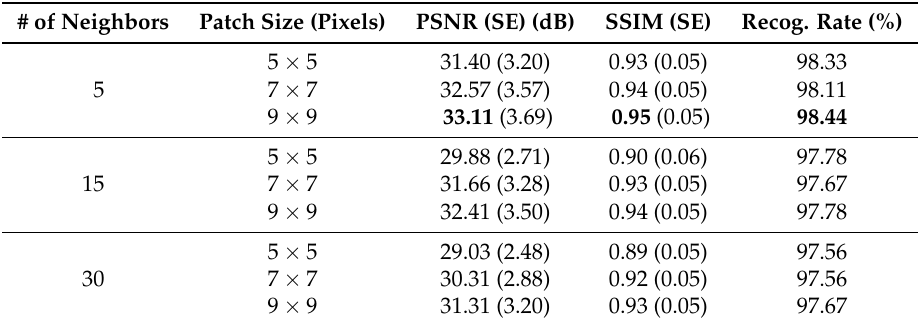
Table 2. Evaluation of various patch sizes with various numbers of neighbors. SE represents the standard